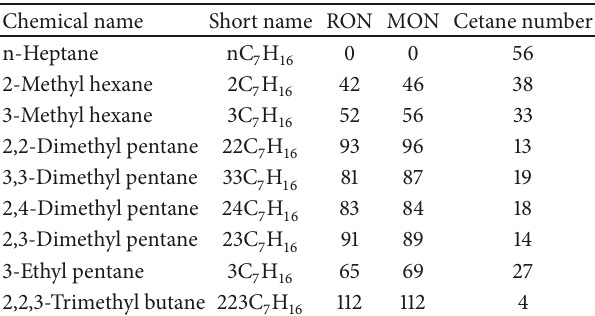
Table 4: Properties of isomers of heptane, adapted from [24]. Chemical name